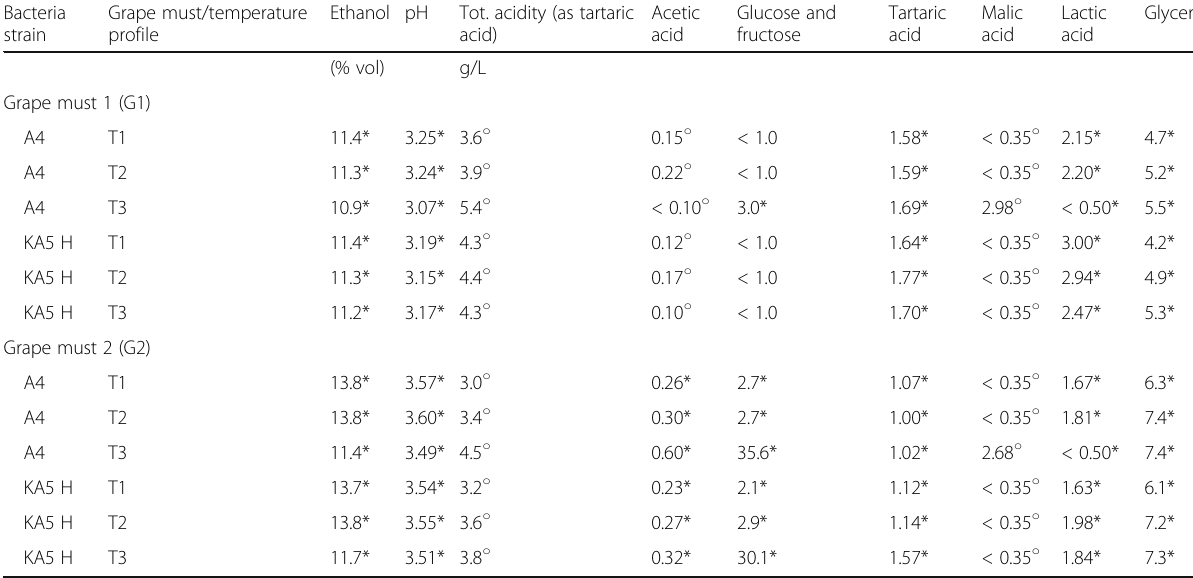
Table 2 Chemical parameters of wines obtained by simultaneous fermentation of S. cerevisiae and L. plantarum or O. oeni at different statistically significant both in terms of bacteria strain and temperature profile effect (two-way ANOVA test, p = 0.05).°Differences are statistically significant in terms of temperature effect (two-way ANOVA test, p =